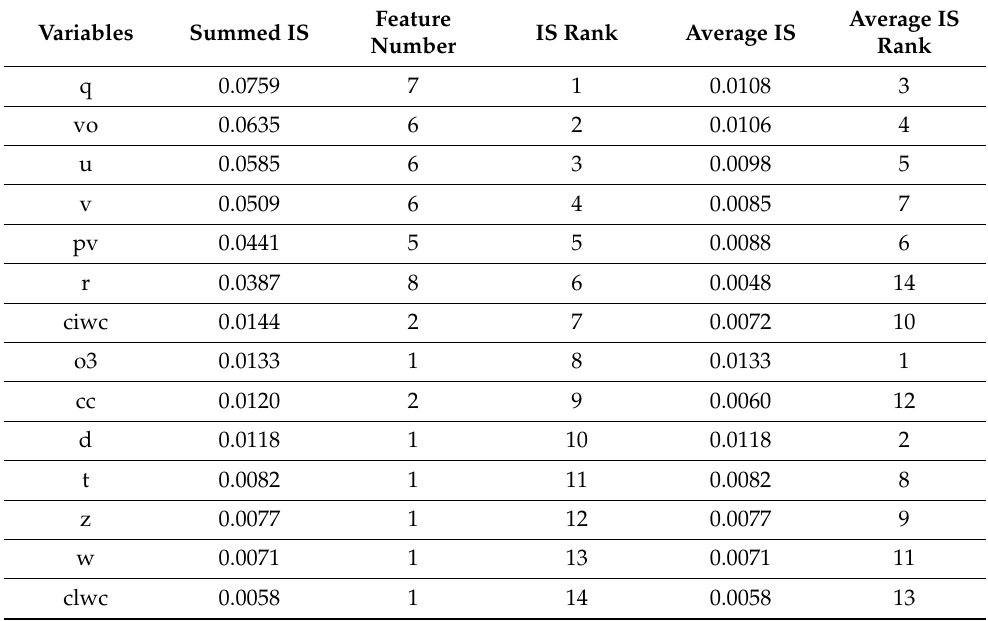
Table 7. Summed variable importance score and its ranking, the number of non-zero, non-correlated features, the feature-wise averaged importance score, and its ranking for each ERA-Interim